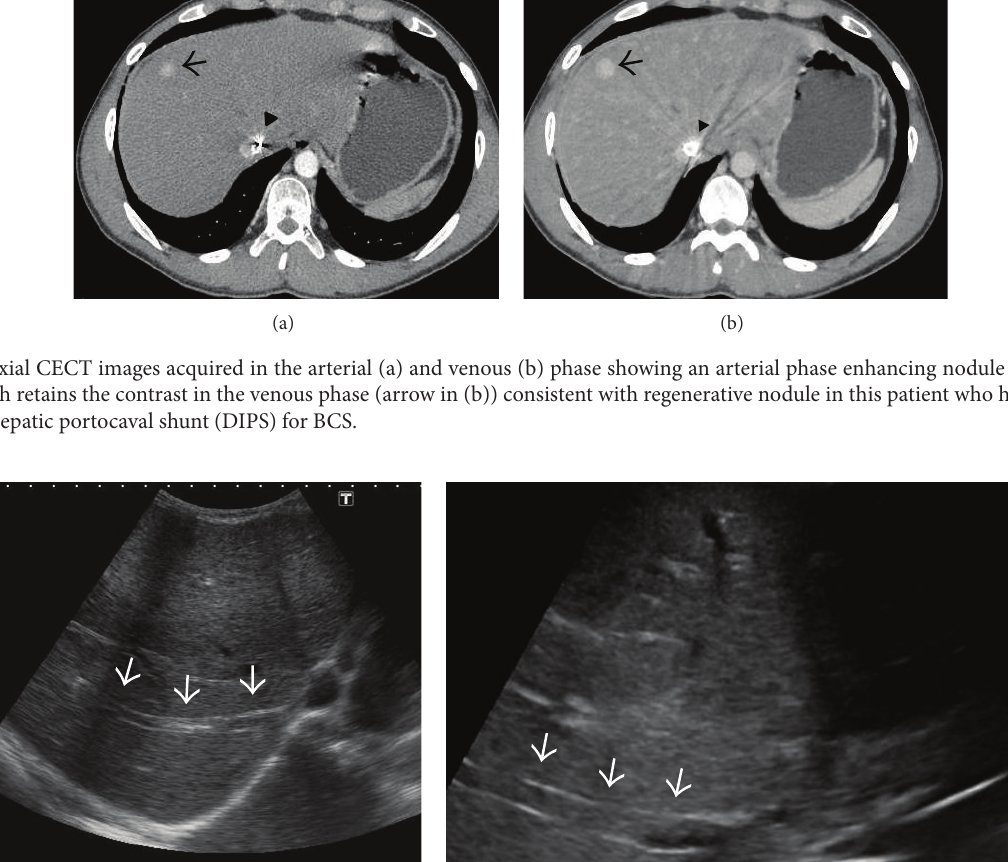
may be a partial or complete nonvisualization of the HV